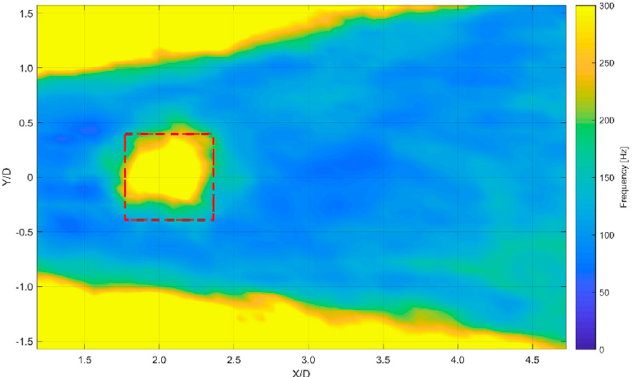
Figure 21. Spatial distribution of frequency content associated with integral time scales in turbulent field ( 1 𝜏⁄ ) , scaled appropriately to the wake region only.